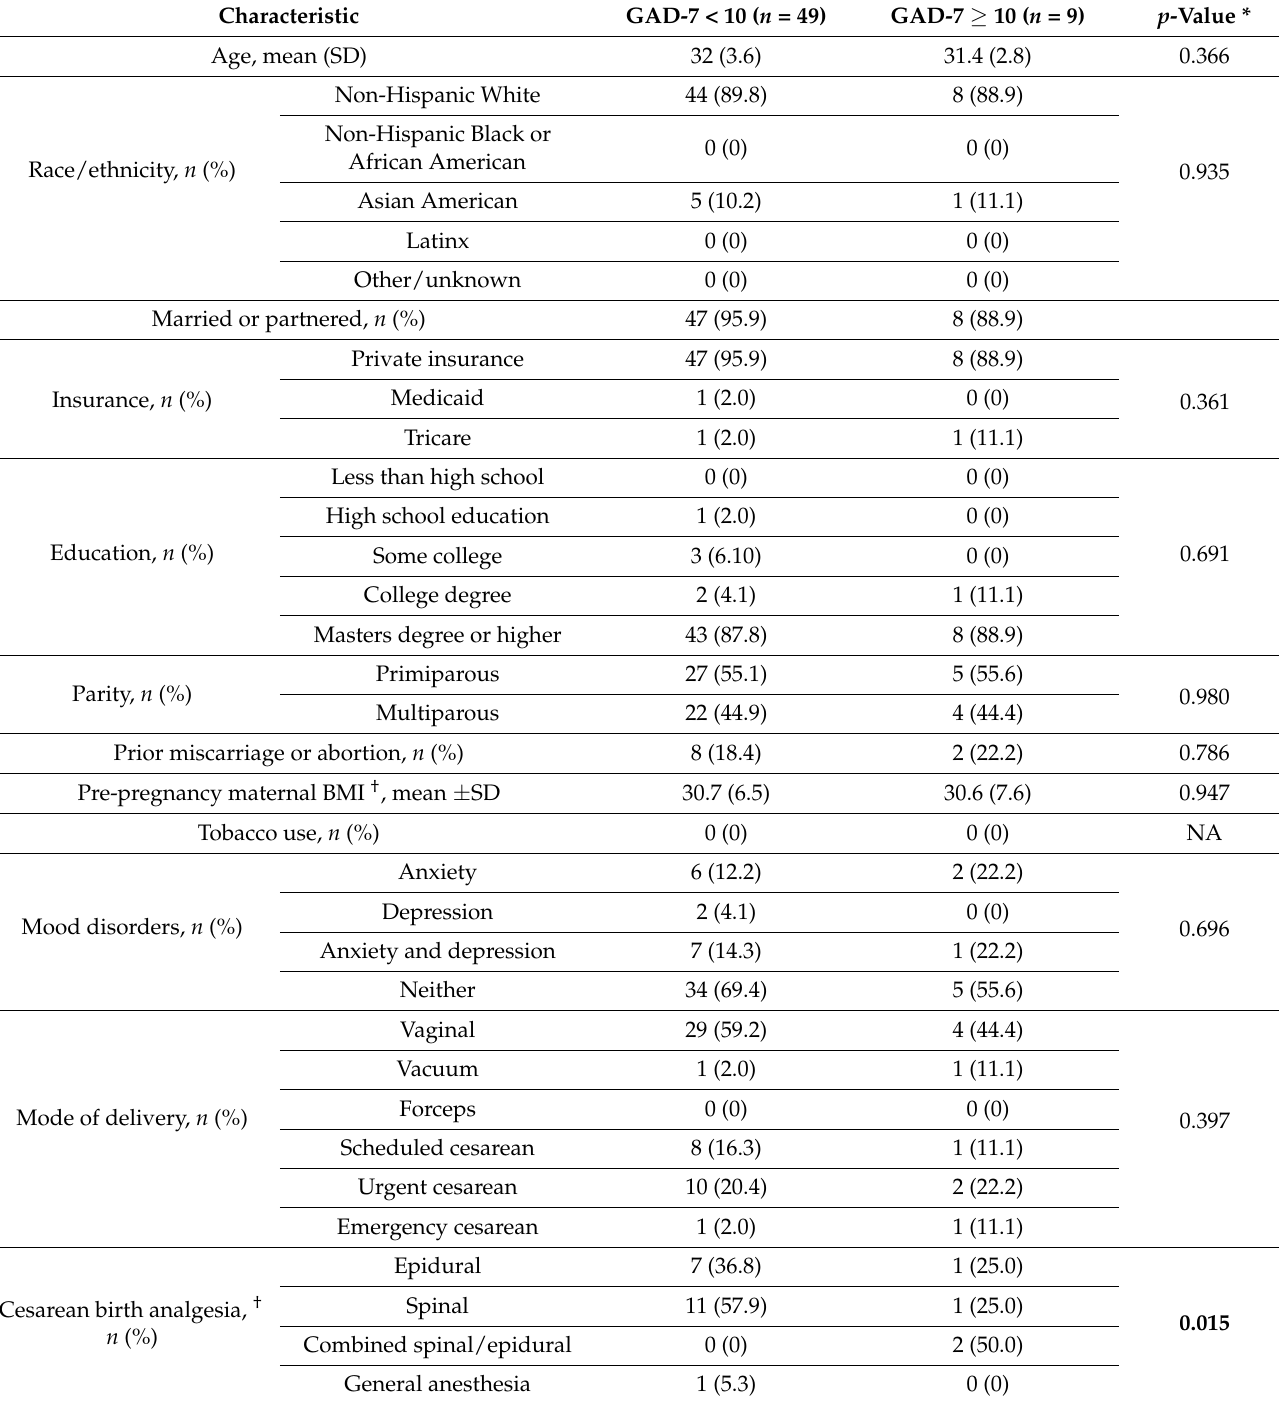
Table 5. Baseline and delivery characteristics of participants in the 6-week postpartum